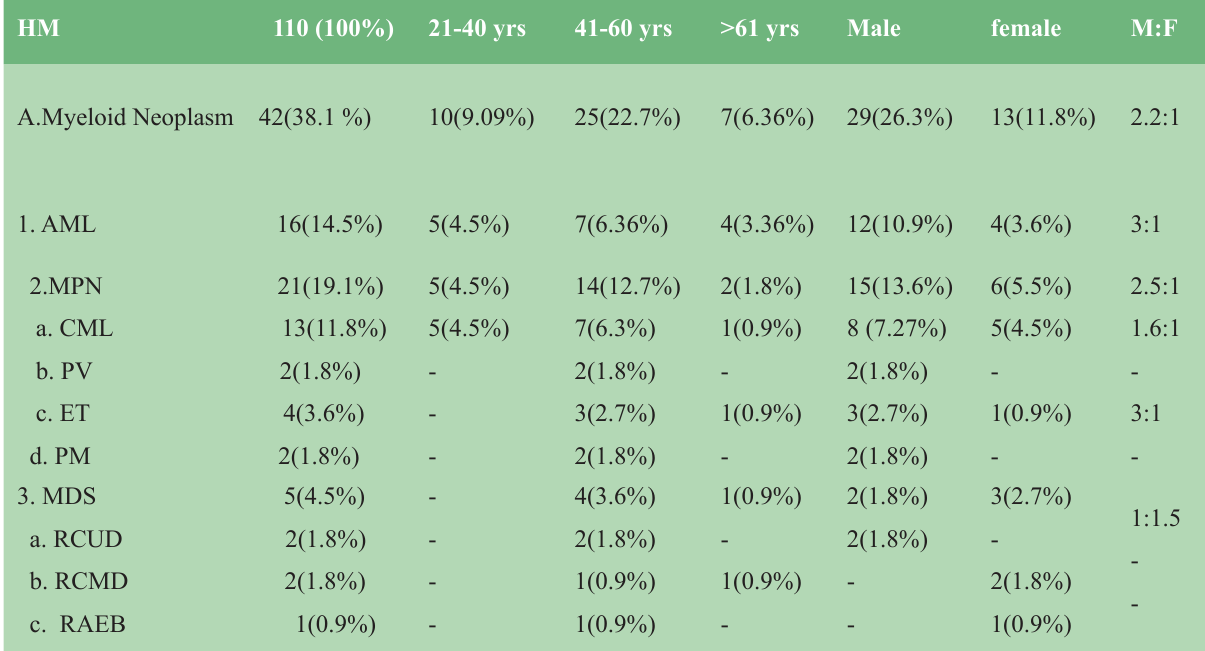
Table 2 Frequency and Distribution pattern of age (years) and sex in Myeloid Neoplasm